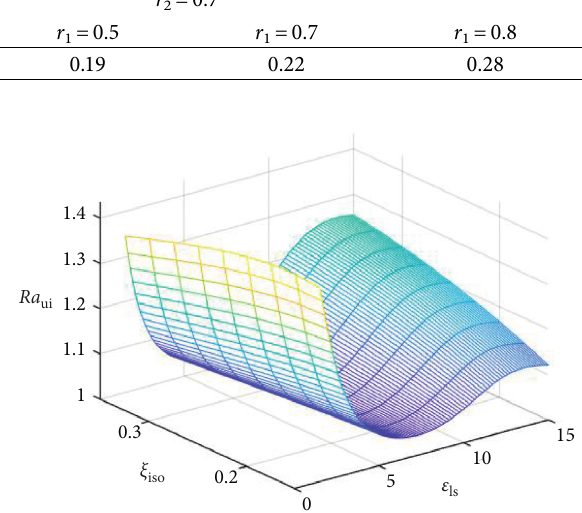
Figure 8: Contour plot of Ra